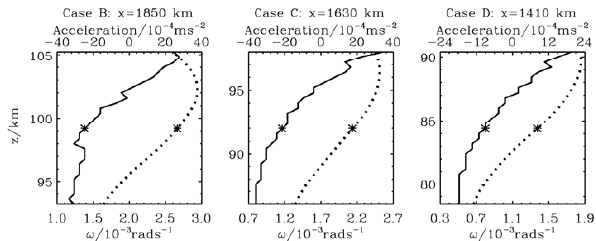
Fig. 5. Height variations of the ground-based GW frequency (solid curves) and the tidal horizontal-wind acceleration (dotted curves) at 12h between the first and second critical layers for cases B and C and below the first critical layer for case D.